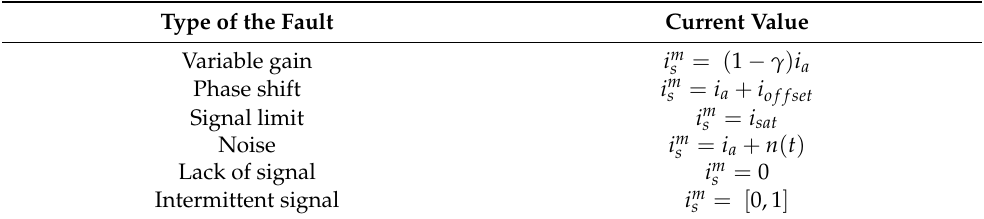
Table 2. Typical fault types of the current